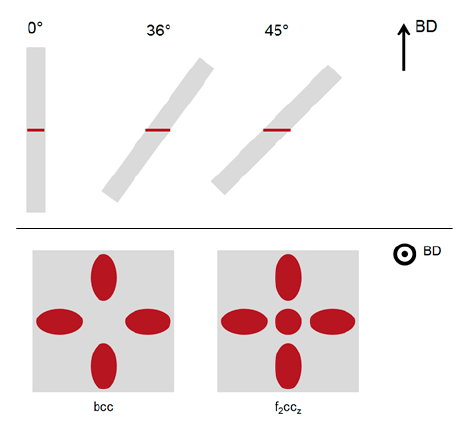
Figure 10. Irradiated cross sections of bcc and f2ccz lattice structures for an arbitrary layer highlighting the impact of strut inclination.